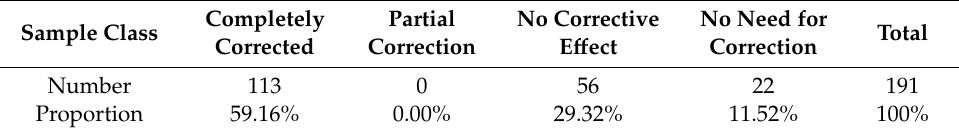
Table 9. Sample-based analysis of Sample Set 2 before and after